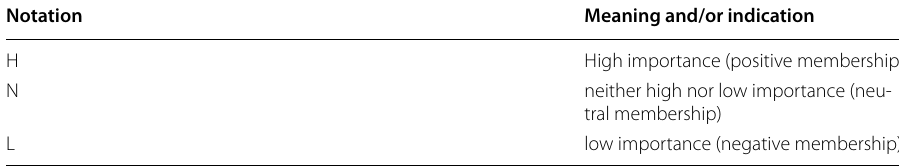
Table 1 Linguistic scale for weighting the criteria